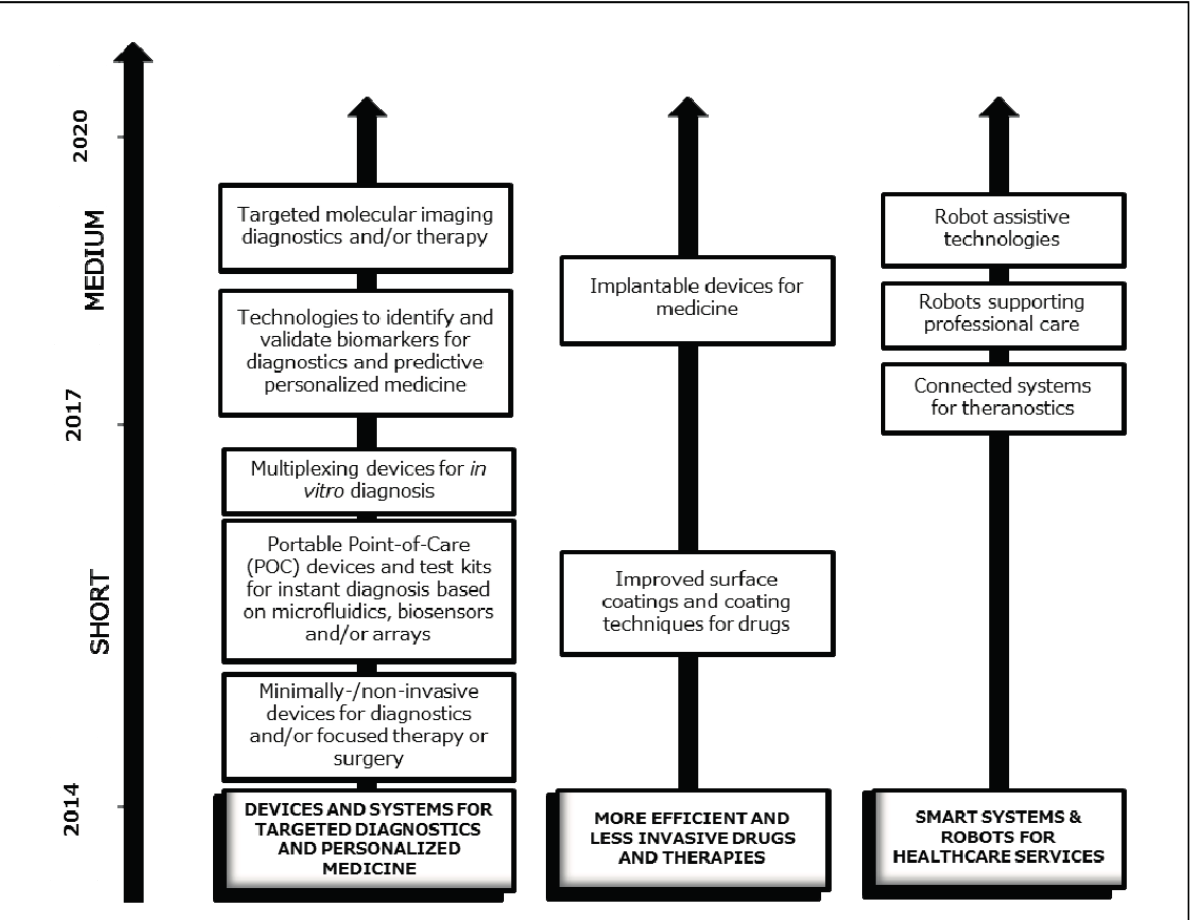
Figure 11. Fields for cross-cutting KETS developments in the Health and Healthcare Domain